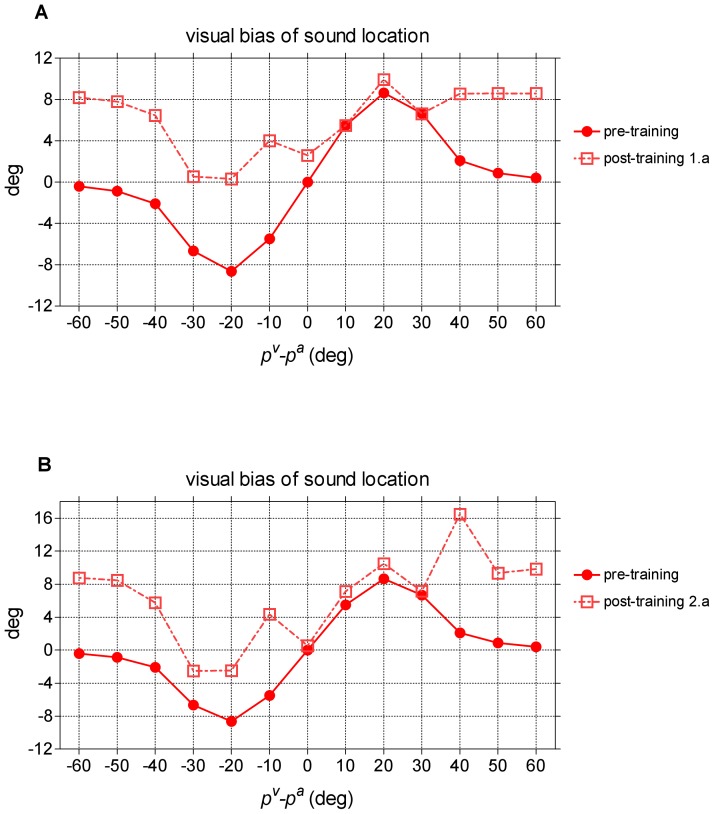
Visual bias of sound location after training.(A) Visual bias of sound location predicted by the model after training paradigm 1.a. The auditory stimulus was maintained fixed at position 100° (the position used during training), while the visual stimulus was located at different positions from 40° to 160° (visual-auditory angular separation ranging from −60° to 60°). The shift in sound location, computed in steady-state conditions, is displayed as a function of the visual-auditory angular separation. For the sake of comparison, results obtained before training are displayed too. (B) Visual bias of sound location predicted by the model after training paradigm 2.a. The same audio-visual stimulation as in panel A was performed, to compute the sound shift for different audio-visual disparities. The meaning of the symbols was the same as in panel A. Since training paradigm 2 involved all the acoustic space, the results displayed in the figure remain substantially unaltered for any position of the auditory stimulus.